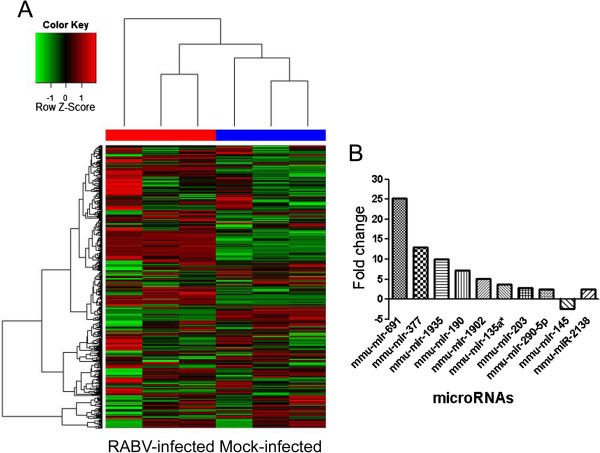
MiRNA profile of street RABV-infected mouse brain. (A) Two-way hierarchical cluster heat map showing all significantly expressed miRNAs in three independent samples (P < 0.01). Each row shows the relative expression level of a single miRNA. Each column shows the expression level of a single sample. Up-regulated miRNAs are shown in red and down-regulated miRNAs are shown in green. Significantly differentially expressed miRNAs in mouse brain upon RABV infection by microarray analysis. MiRNAs whose relative expression levels showed a fold change (FC) ≥ 2 and P ≤ 0.01 were considered significantly up-regulated, and those with FC ≤ −2 and P ≤ 0.01 were considered significantly down-regulated.